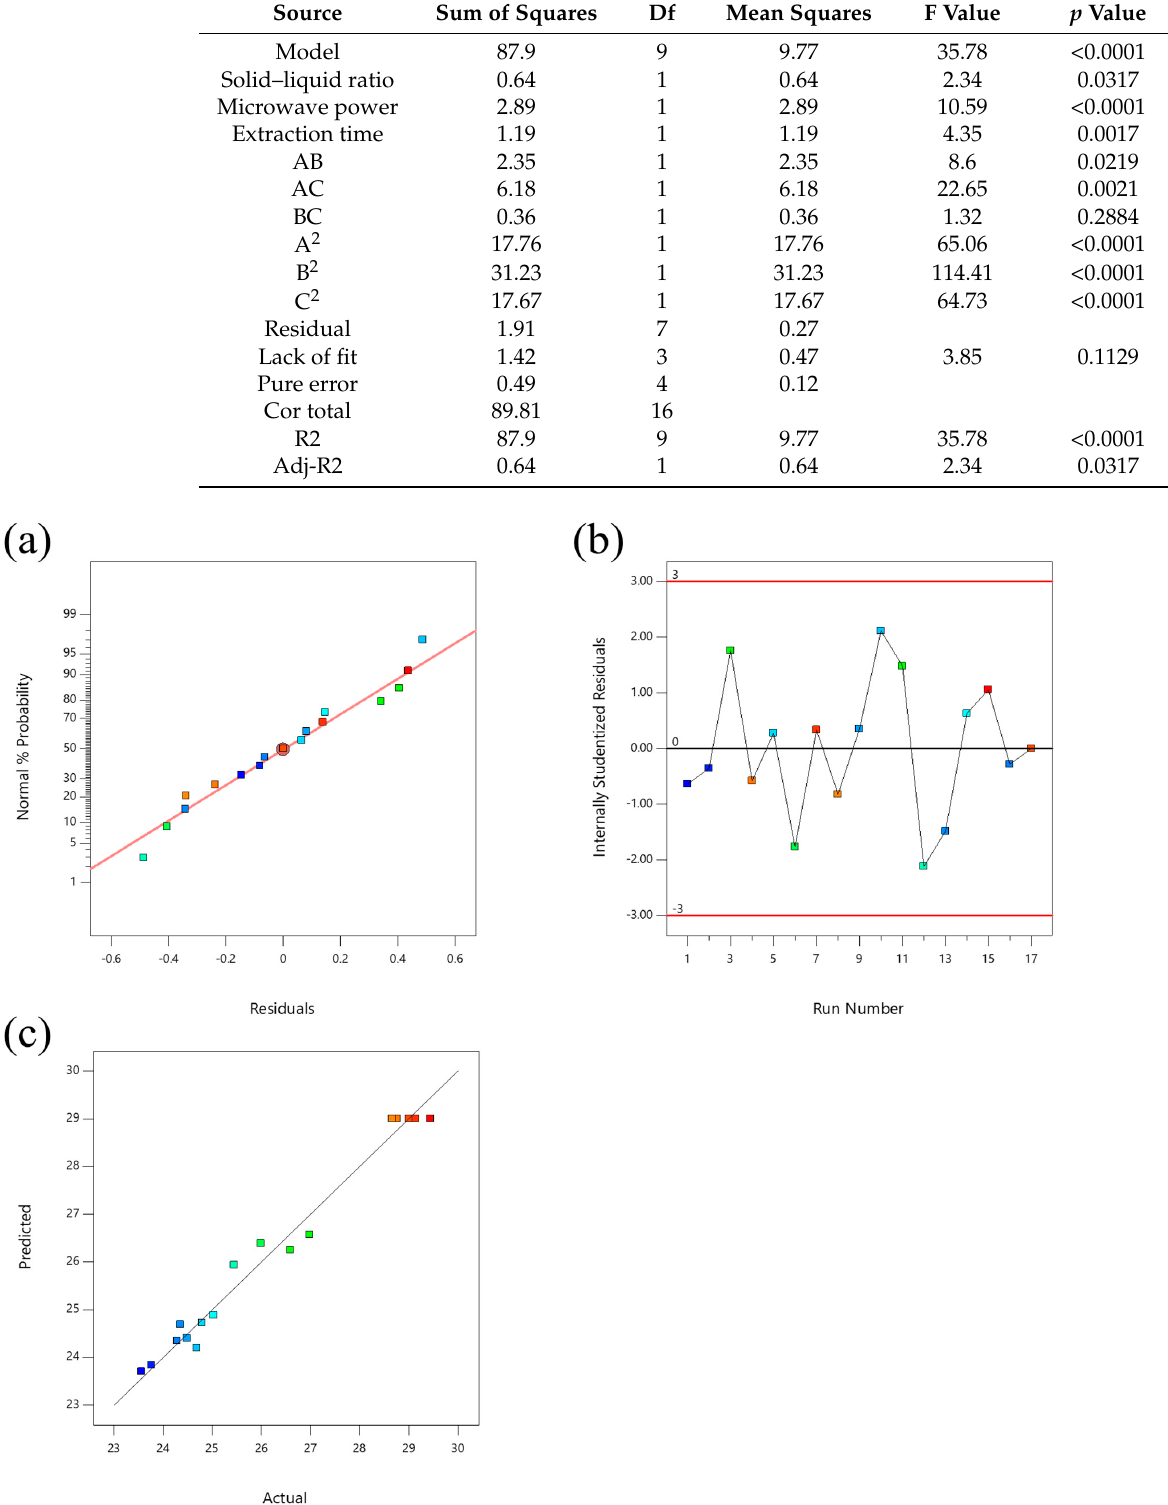
Figure 2. Diagnostic plots for model adequacy for extraction of TTC. ( a ) Residual normal probability plot; ( b ) studentized residuals; ( c ) predicted and actual values. The data points with di ff erent colors in the fi gure represent the test groups with di ff erent TTCs.